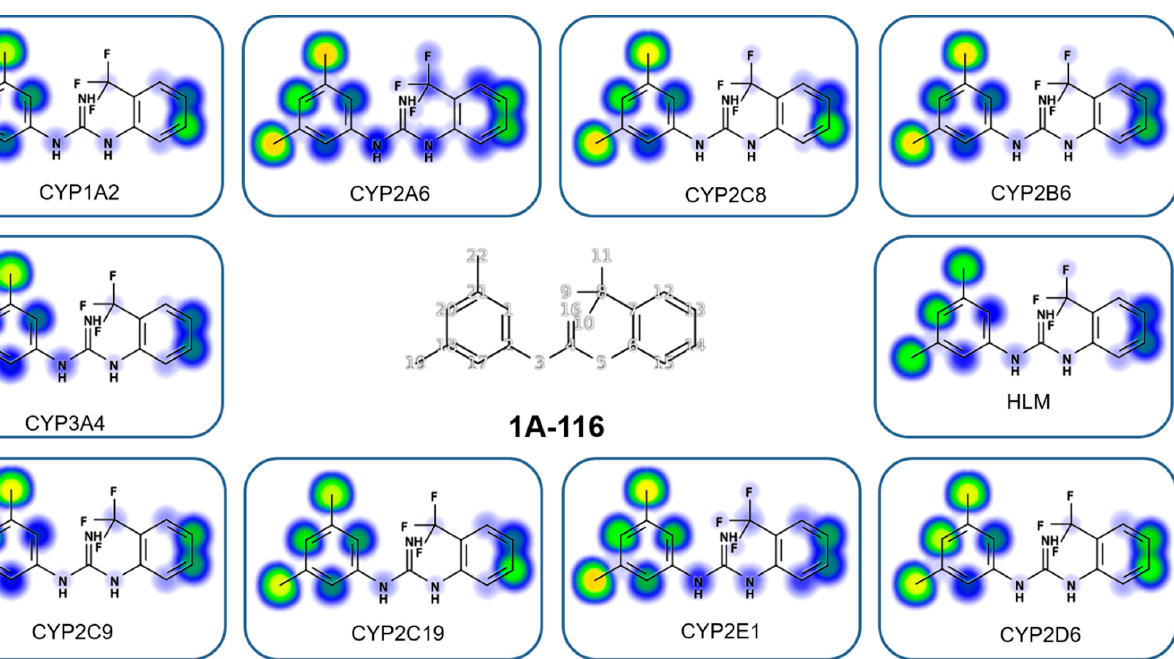
Table 1. Hematology and serum chemistry parameters of mice treated with 1A-116 and controls.